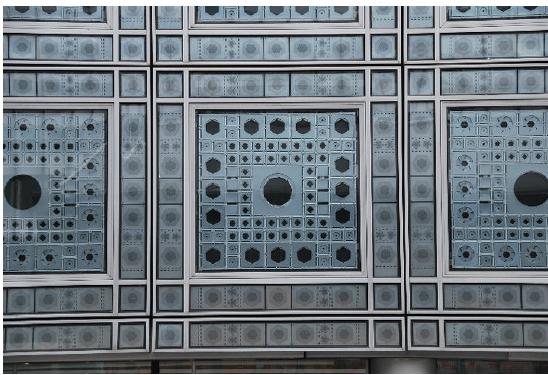
Figure 13. Institut du Monde Arabe, Paris France—Jean Nouvel (Courtesy Terri Boake, University of Waterloo).